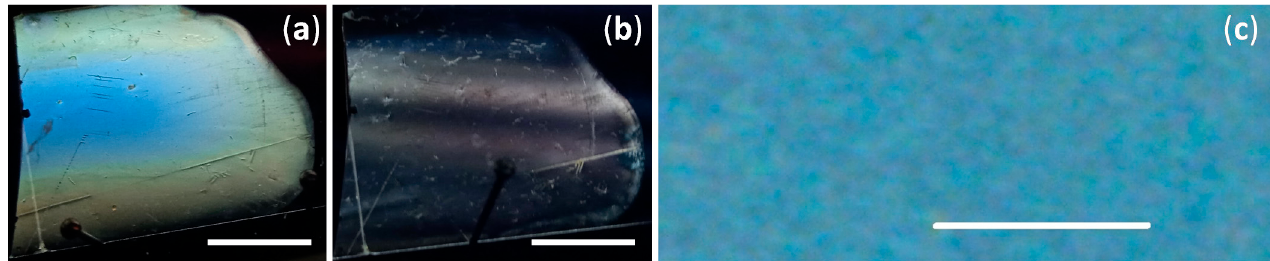
Figure 2. Photography of a CNC film through ( a ) left and ( b ) right circular polarizers. ( c ) Polarized optical microscopy (POM) image in reflection mode. Scale bars are 1 cm in ( a ) and ( b ), and 250 m in ( c ).